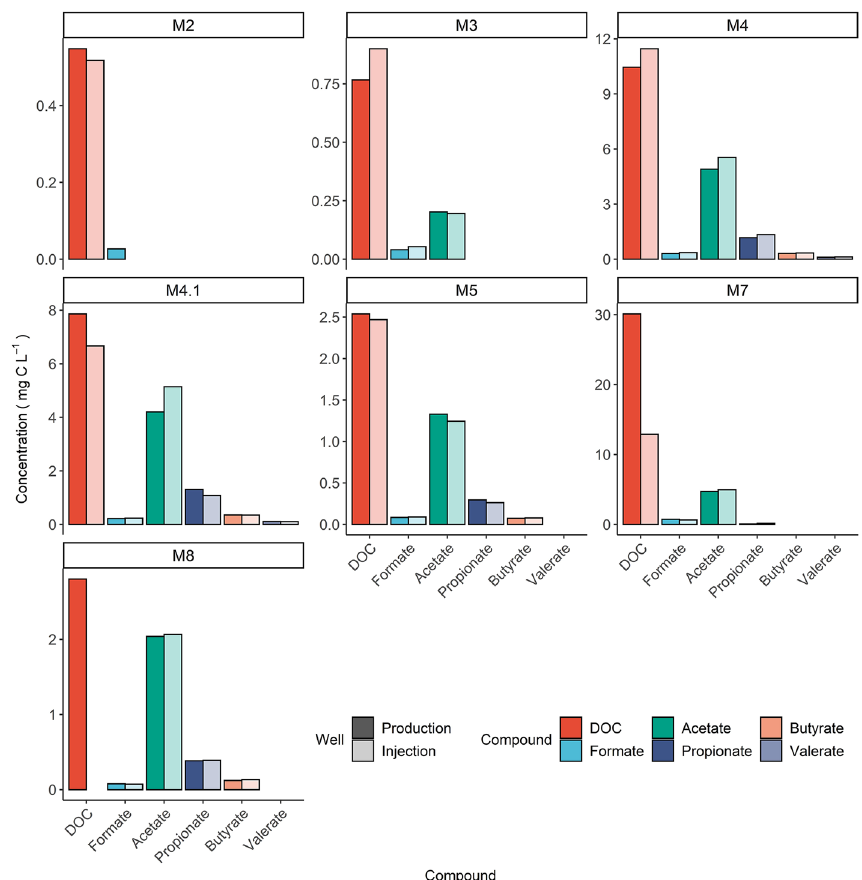
Fig. 9 Average DOC, formate, acetate, propionate, butyrate, and valerate concentrations ( mgCL − 1 ) in samples from production (dark fill) and injection (clear fill) well of the Molasse Basin sites. Missing data represent either data below detection limit or not reported